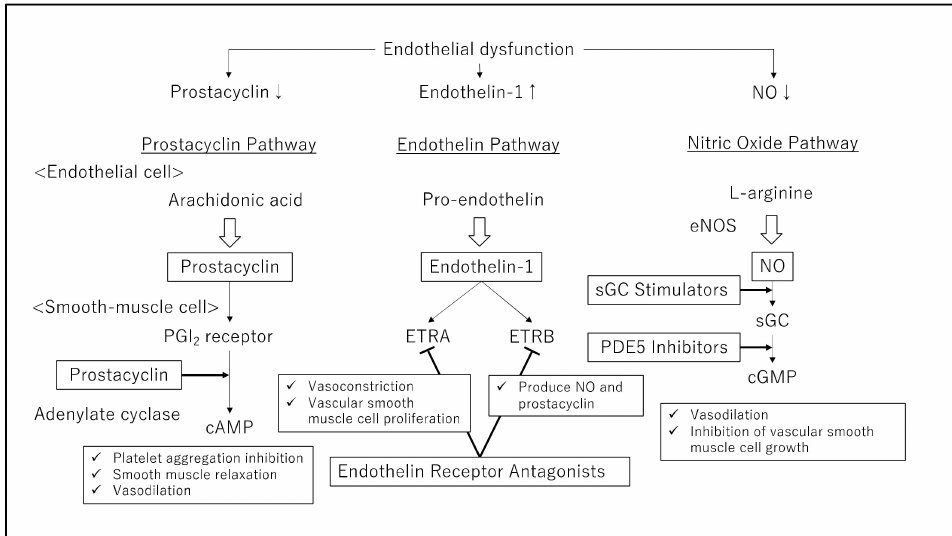
Figure 1. Three pathways of targeted therapeutic agents for pulmonary artery hypertension. Current therapeutic agents are targeted at correcting endothelial dysfunction by inhibiting the endothelin pathway and enhancing the prostacyclin or nitric oxide (NO) pathway. PGI2: prostaglandin I2; ETRA: endothelin A receptor; ETRB: endothelin B receptor; eNOS: endothelial isoform of nitric oxide synthase; sGC: soluble guanylate cyclase, PDE5: phosphodiesterase type 5, cAMP: cyclic adenosine monophosphate; cGMP: cyclic guanosine